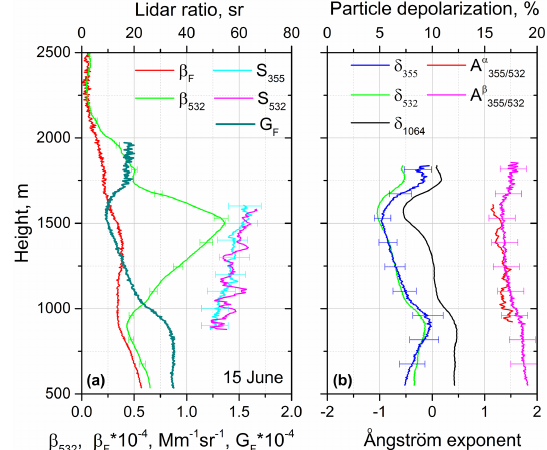
Figure 7. Lidar measurements in the condition of aerosol hygro- scopic growth in the 900–1500m height range. Vertical profiles of (a) particle β 532 and fluorescence β F backscattering coefficients, fluorescence capacity G F , lidar ratios S 355 and S 532 , and (b) parti- cle depolarization ratios δ 355 , δ 532 and δ 1064 together with extinc- tion A α and backscattering A β Ångström exponents 355 / 532 355 / 532 measured on 15 June 2020 at